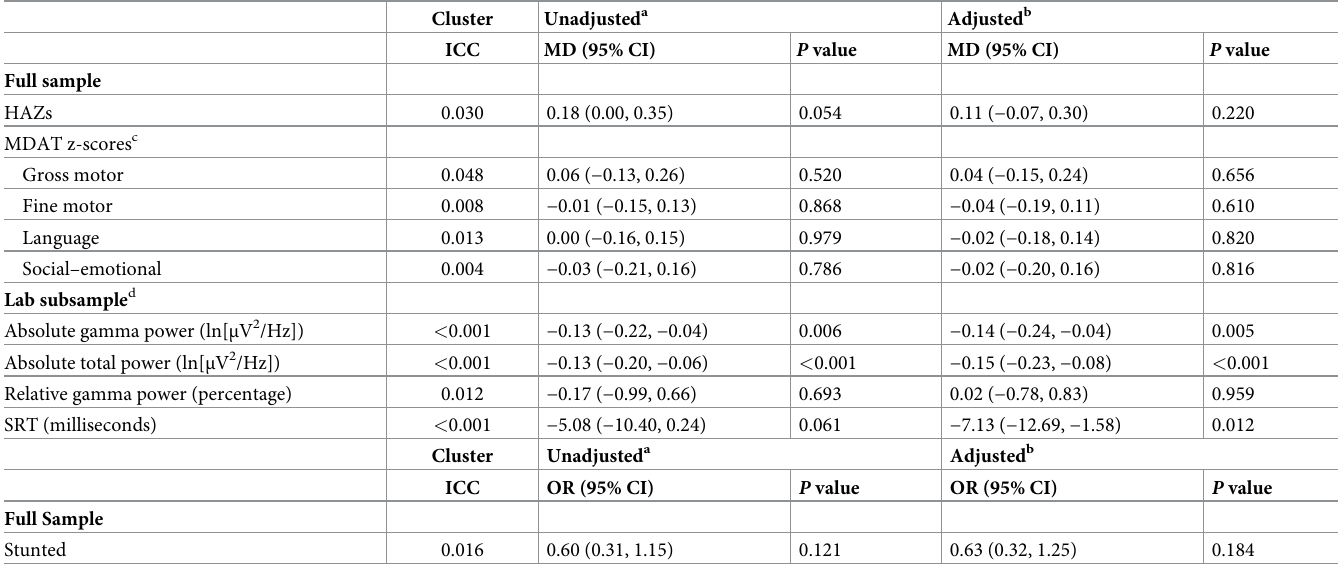
Table 2. Impact on primary